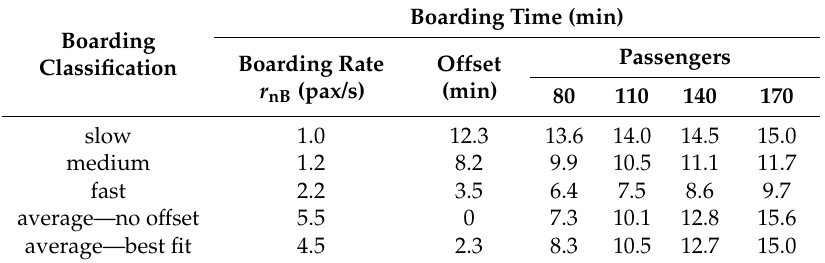
Table 1. Boarding time using different classifications of linear behavior (slow, medium, fast, and average).